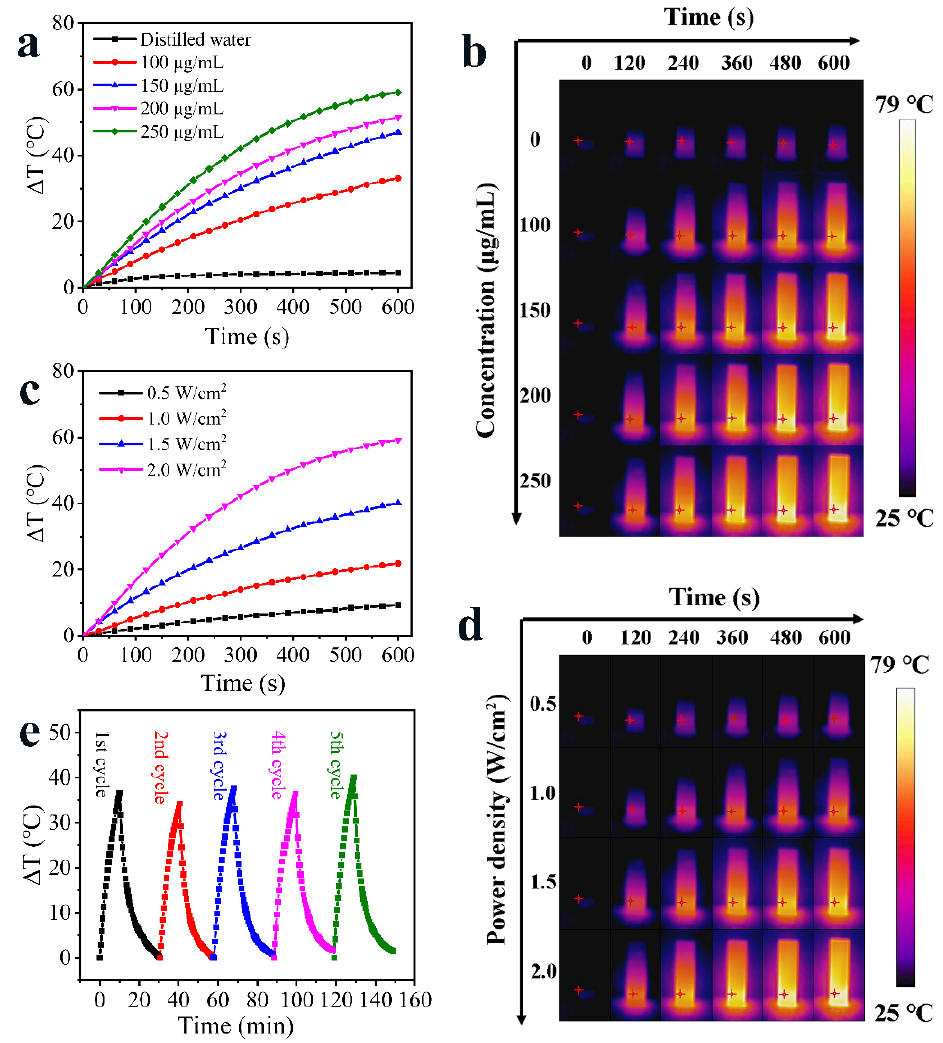
Figure 7. Temperature elevation curves of HAg 2 S@HMPDA/LA nanocarriers with various concentrations under 808 nm irradiation (2 W/cm 2 ) ( a ) and the related IRT images ( b ); temperature elevation curves of HAg 2 S@HMPDA/LA nanocarriers (250 µ g/mL) at various irradiation power densities of 808 nm irradiation ( c ) and the related IRT images ( d ); temperature variation curves of HAg 2 S@HMPDA/LA nanocarriers under five irradiation/cooling cycles ( e ).